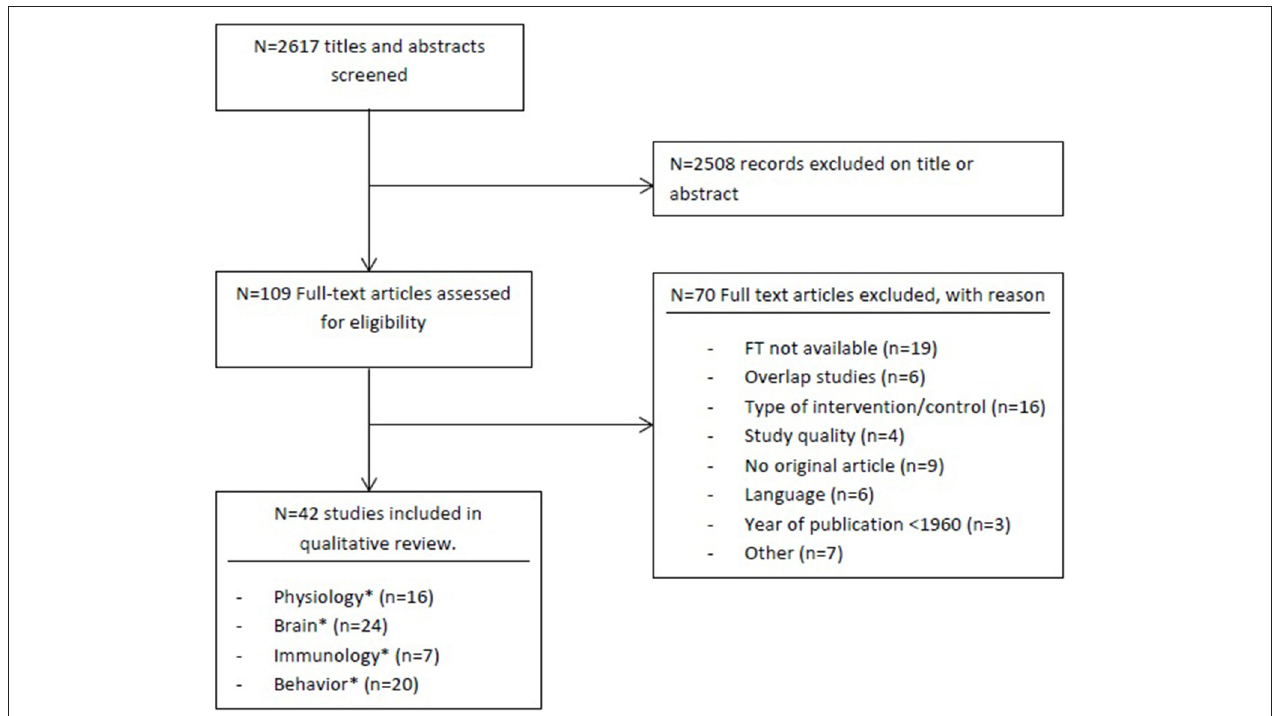
FIGURE 1 | Flowchart. * Some studies investigated outcomes on several areas.